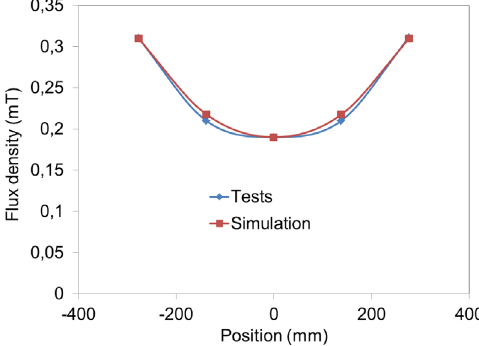
Figure 6. Comparison of the simulated and measured fl ux density inside the reactor Coil55.